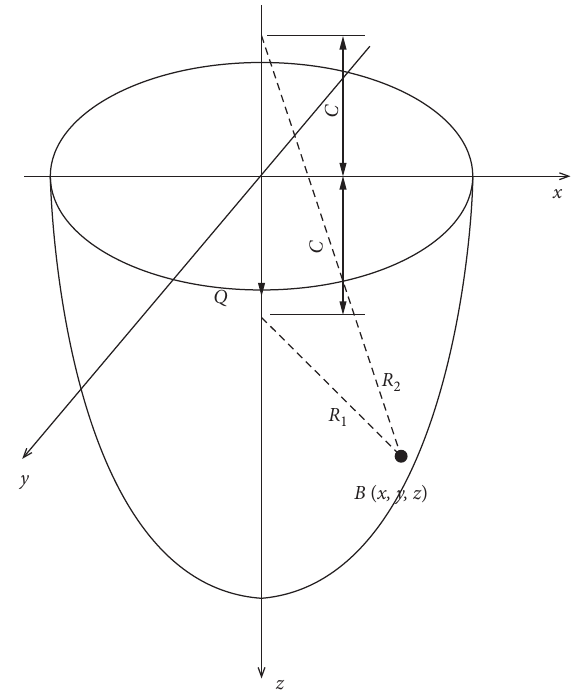
Figure 18: Calculation diagram of Mindlin displacement